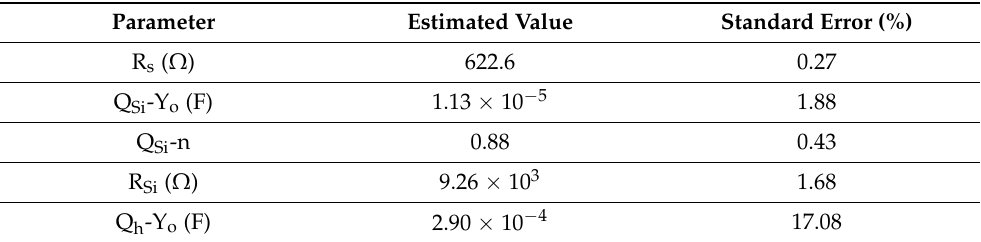
Table 4. Corrosion of BTSE coated AZ91D (with prior dipping in hydroxide), after im- mersion in 0.01 M Na 2 SO 4 solution: Calculated parameters for components in